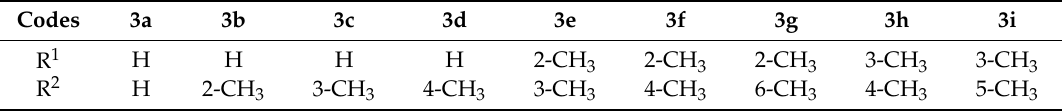
Table 1. Different substitutions in 3a – 3i